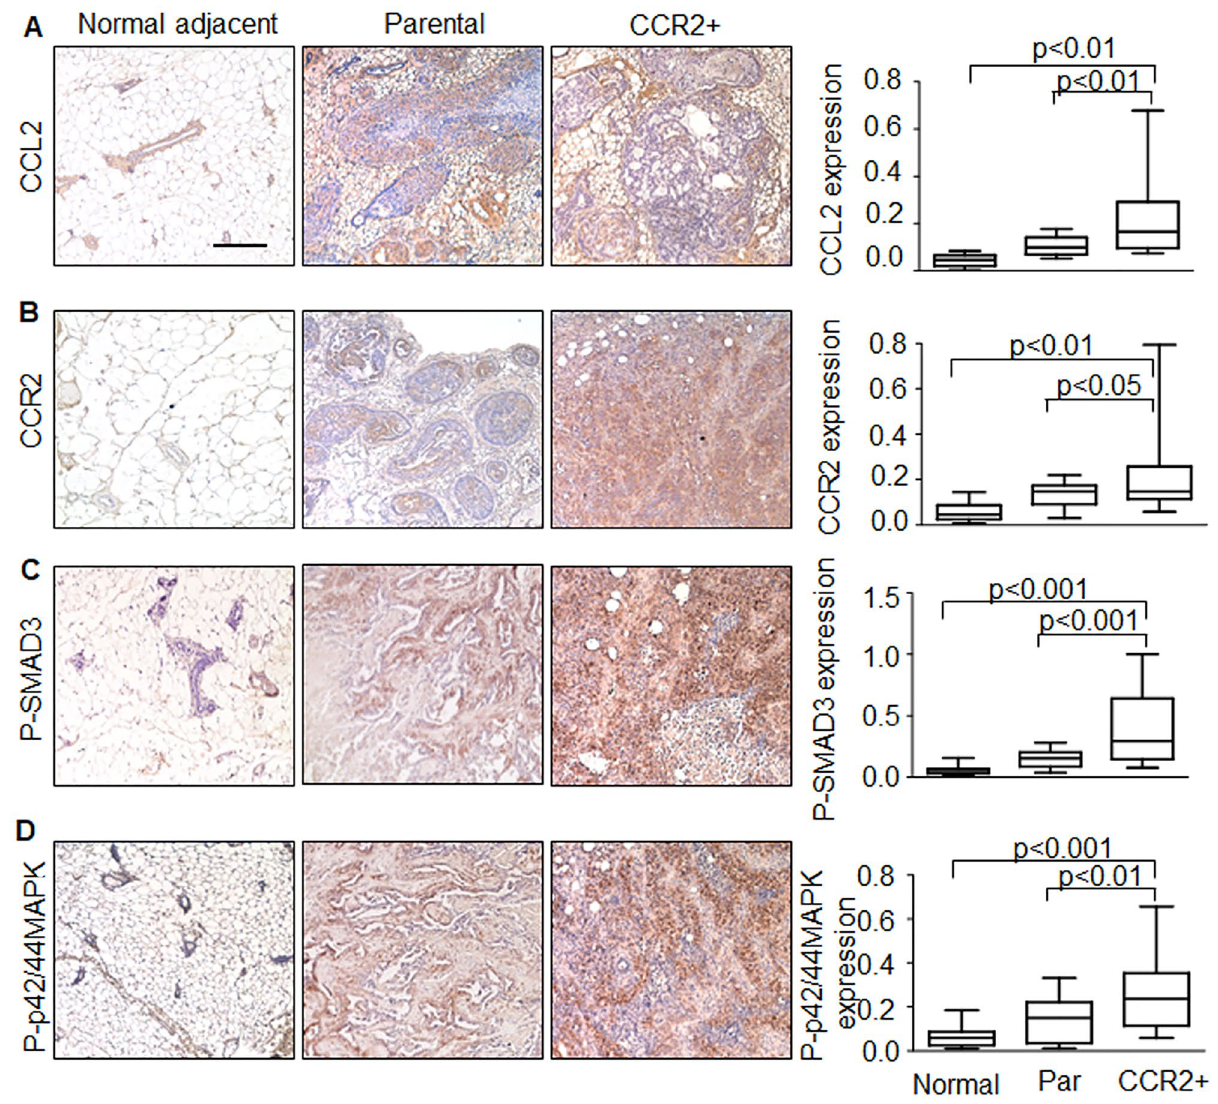
Figure 4. hDCIS.01 xenografts enriched for CCR2 expression show increased CCL2, phospho-SMAD3 and phospho-p42/44MAPK expression. hDCIS.01 xenografts were immunostained for expression of: ( A ) CCL2, ( B ) CCR2, ( C ) phospho-SMAD3 or ( D ) phospho-p42/44MAPK. Normal adjacent tissues were from parental lesions. Normal adjacent n = 12, parental n = 14, CCR2+ n = 12. Expression was quantified by Image J. Statistical analysis was performed using One Way ANOVA with Bonferroni post-hoc comparison. Whisker box plots are shown. Whiskers indicate min and max values. Box indicates upper and lower quartile range. Line indicates median. Statistical significance was determined by p < 0.05. Scale bar = 200